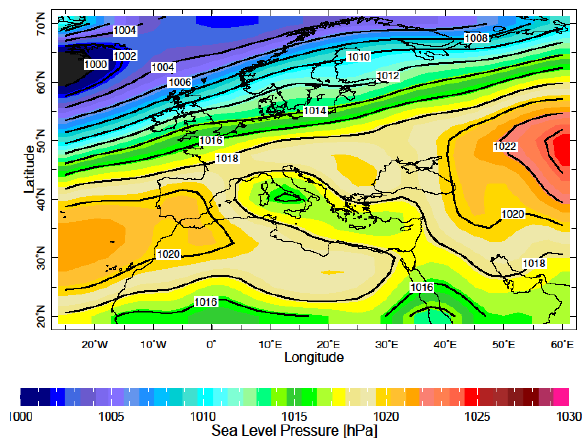
Fig. 5. Long-term mean sea level pressure for DJF based on the 788 observations, in